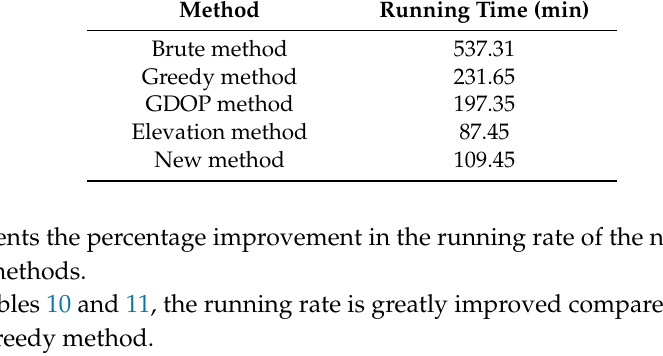
Table 10. Running time of different methods.